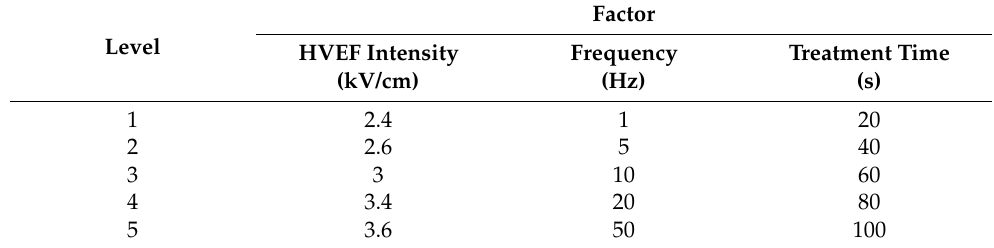
Table 1. Orthogonal test